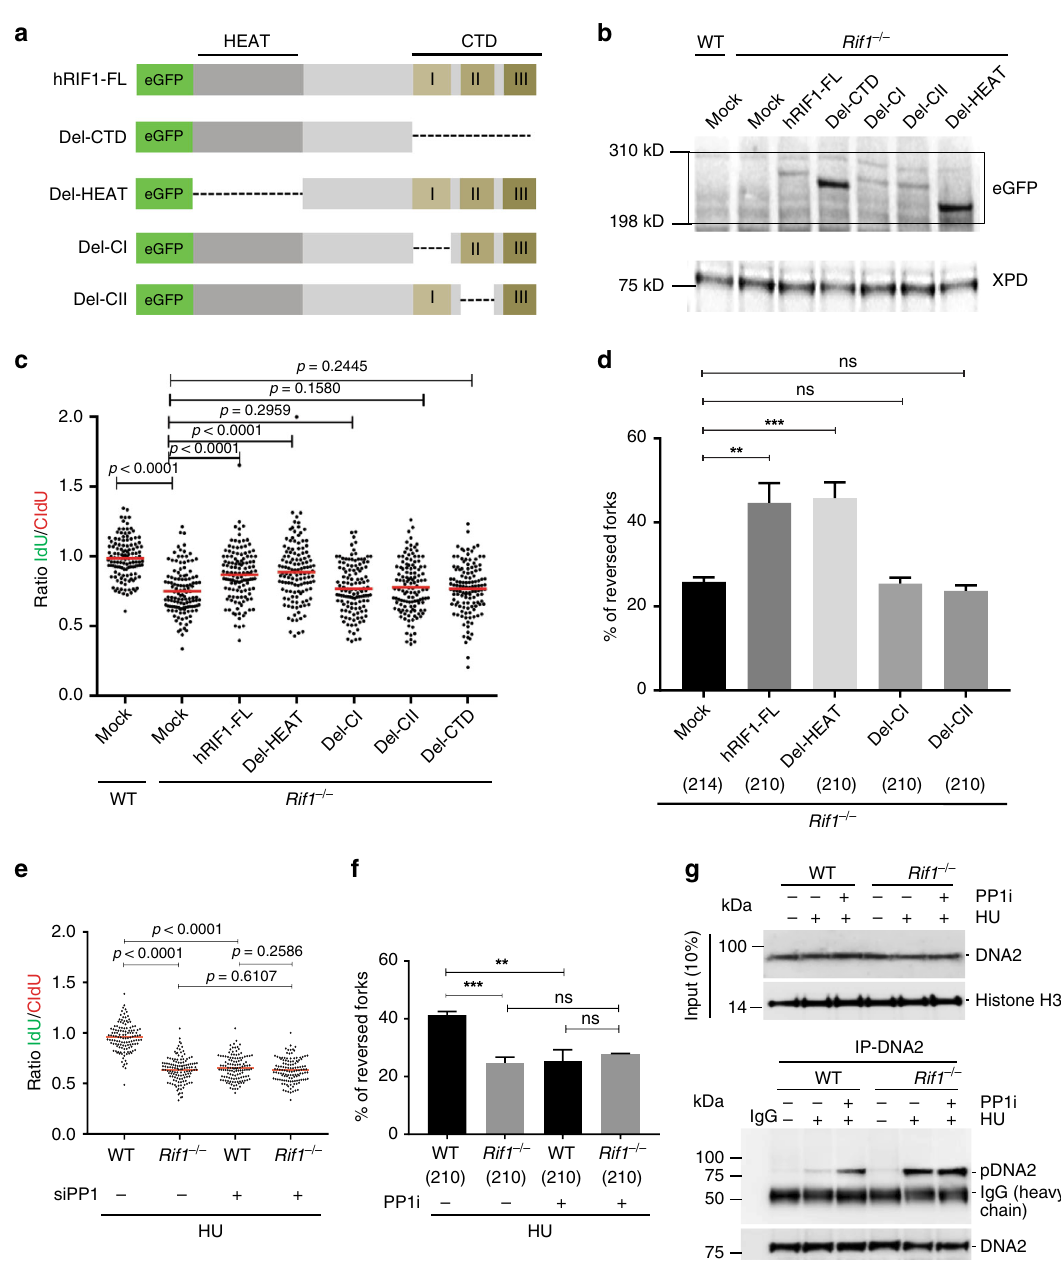
Fig. 4 C-terminal region of RIF1 protects of reversed forks from degradation. a Schematic of full-length (FL) human RIF1 protein and deletion mutant constructs. Deleted region for each mutant is denoted by dotted line. b Western blot analysis for Rif1 − / − MEFs transfected with mutant construct of human RIF1. Lysates were probed with antibody against GFP. XPD was used as loading control. Expression of mutant protein is visualized as distinct bands in range of 198 kD to 310 kD, which is missing in mock-transfected samples. c DNA fi ber assay to assess the rescue of Fork degradation in Rif1 − / − MEFs transfected with RIF1 mutant constructs (for 48 h) upon treatment with 4 mM HU for 3 h. d Percentage of fork reversal in Rif1 − / − MEFs transfected with different mutant constructs of human RIF1 and subsequent treatment with HU for 3 h (4 mM). Numbers of analyzed molecules are indicated in parentheses. e DNA fi ber assay to determine the extent of fork degradation in WT and Rif1 − / − MEFs upon siRNA-mediated downregulation of PP1. f Percentage of reversed forks observed in WT and Rif1 − / − MEFs treated with 4 mM HU for 3 h with or without inhibiting PP1. Number of molecules analyzed are indicated within the parenthesis. At least 125 readings were taken for c and e and the mean values are represented by red bar. P -values were derived from Kruskal – Wallis ANOVA with Benjamini Hochberg post test for c and e and from unpaired t -test for d (ns, non-signi fi cant, *** P = 0.0009, ** P = 0.0025) and f (ns, non- signi fi cant, *** P = 0.0003, ** P = 0.0026). All the experiments were repeated for three times with similar outcomes (Supplementary Data 2 and Supplementary Fig. 8a, b). g DNA2 is hyper phosphorylated in Rif1 − / − MEFs during replication stress. Top panel: level of DNA2 in nuclear extracts from blots were performed with antibody against DNA2 antibody. Histone H3 was used as loading control. Bottom panel: Immunoprecipitations were carried out with anti-DNA2 antibody or the corresponding IgG and were probed with p-(S/T)